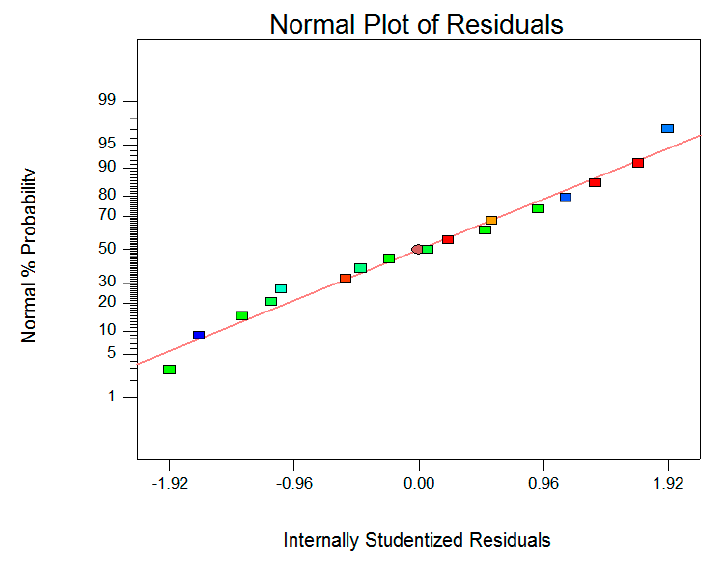
Figure 3. The response surface plots for the effects of microwave power (W) and ethyl acetate concentration (%) on the α -mangostin content of G. mangostana . ( A ) Three-dimensional (3D) view; ( B ) flat view.